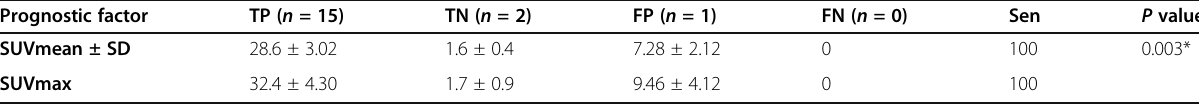
Table 8 The diagnostic value of SUVmean and SUVmax for G3, n = 18 patients of suspicion of distant metastases Prognostic factor